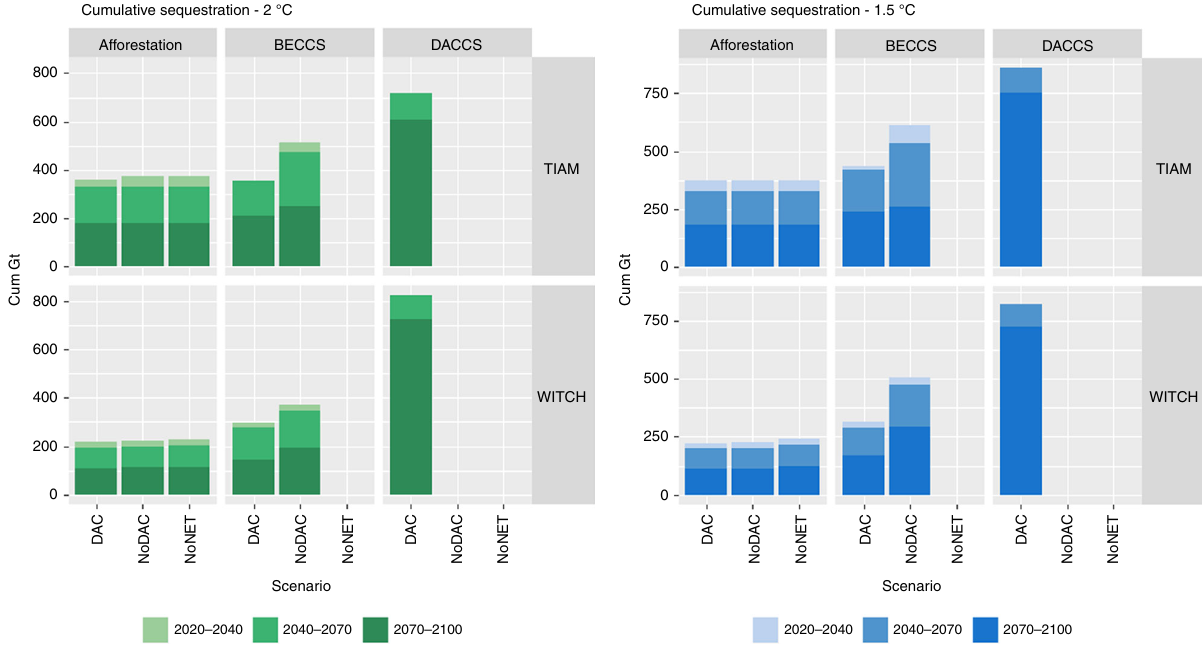
Fig. 2 Cumulative sequestration of negative emissions technologies throughout the century in central case scenarios, with different temperature